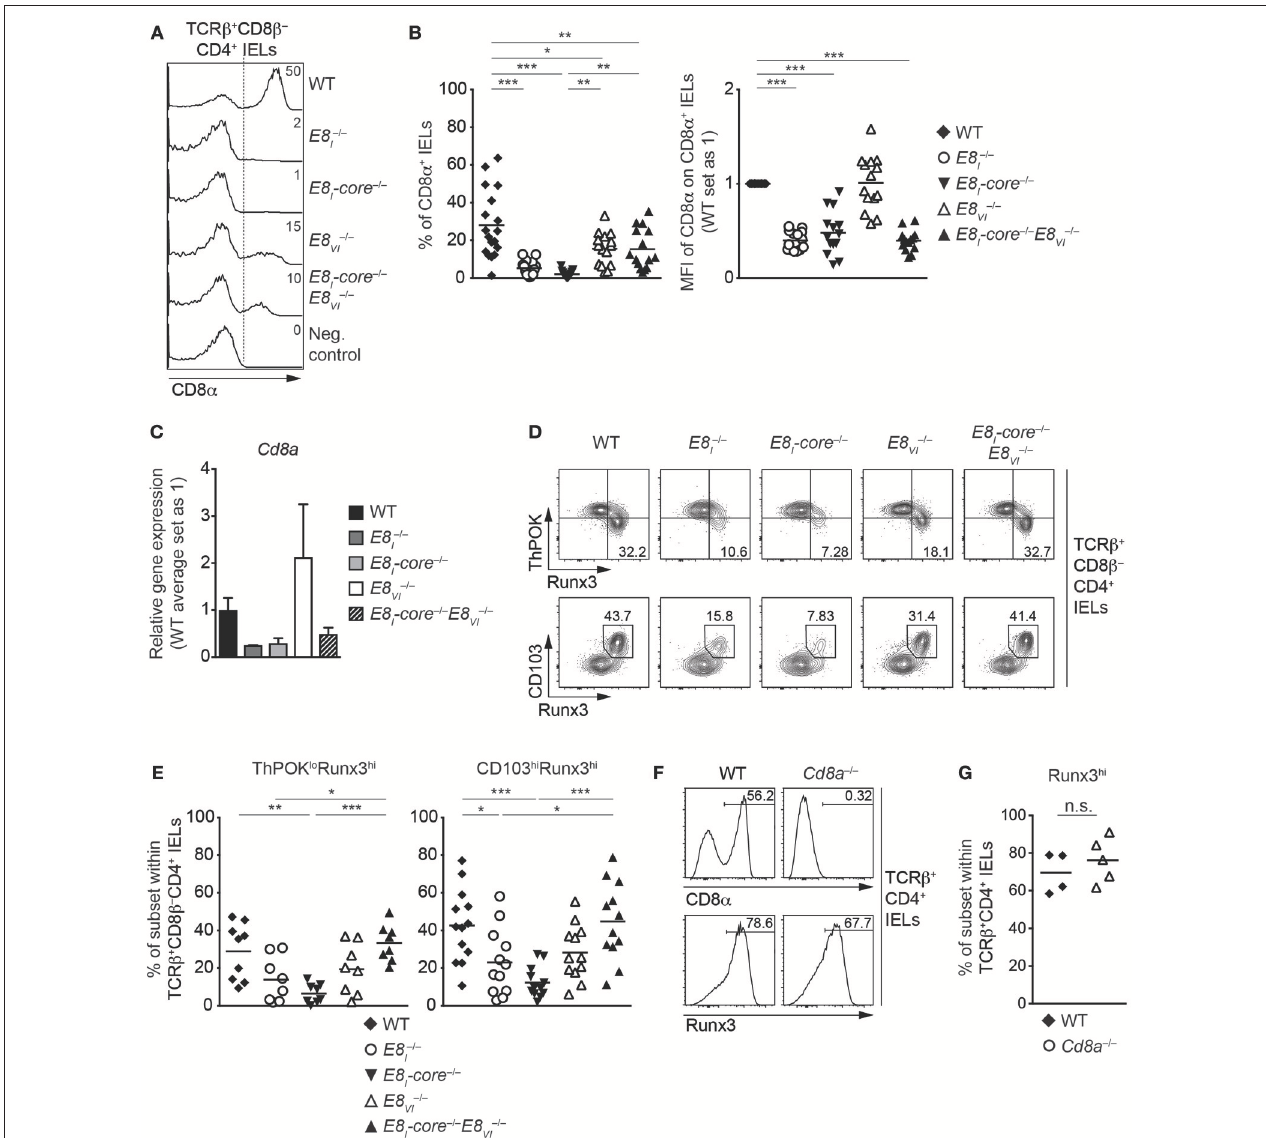
FIGURE 7 | E8 I -core is required for the generation of CD4 + CTLs in the small intestine. (A) Histograms showing CD8 α expression on TCR β + CD8 β − CD4 + IELs isolated from wild-type (WT), E8 I − / − , E8 I - core − / − , E8 VI − / − and E8 I -core − / − E8 VI − / − mice. The gating strategy is shown in Figure 6A . CD8 α expression on WT CD19 + B cells is shown as a negative control for the staining. Dotted lines and numbers indicate gating region for the CD8 α + population and the percentages of the CD8 α + population, respectively. (B) Diagrams showing the percentage of the CD8 α + population (left) and the relative mean fluorescence intensity (MFI) of CD8 α expression on the CD8 α + population (right) within TCR β + CD8 β − CD4 + IELs isolated from wild type (WT), E8 I − / − , E8 I -core − / − , E8 VI − / − and E8 I -core − / − E8 VI − / − mice. Each dot represents one mouse. Horizontal bars indicate mean values. The MFI values of WT cells are set as 1. A one-way ANOVA analysis followed by Tukey’s multiple-comparison test (left) or a one-sample t -test, where the values obtained from each group of the mutant mice were compared to the WT ones (i.e., 1) (right), was performed. (C) qRT-PCR analysis showing Cd8a gene expression levels (normalized to the Hprt gene expression levels) in sorted TCR β + CD8 β − CD4 + IELs from wild-type (WT), E8 I − / − , E8 I - core − / − , E8 VI − / − , and E8 I -core − / − E8 VI − / − mice. The average expression levels in WT cells were set as 1. Error bars indicate SEM. A one-way ANOVA analysis followed by Tukey’s multiple-comparison test was performed for statistical analysis. (D) Flow cytometry analysis showing Runx3 and ThPOK (upper panel) and Runx3 and CD103 (lower panel) expression on TCR β + CD8 β − CD4 + IELs isolated from wild type (WT), E8 I − / − , E8 I -core − / − , E8 VI − / − and E8 I -core − / − E8 VI − / − mice. Numbers indicate the percentages of ThPOK lo Runx3 hi subsets (upper panel) and CD103 hi Runx3 hi subset (lower panel). (E) Diagrams showing the percentages of the ThPOK lo Runx3 hi (left panel) and CD103 hi Runx3 hi (right panel) subsets within TCR β + CD8 β − CD4 + IELs isolated from wild type (WT), E8 I − / − , E8 I -core − / − , E8 VI − / − and E8 I -core − / − E8 VI − / − mice. Each dot represents one mouse. Horizontal bars indicate mean values. A one-way ANOVA analysis followed by Tukey’s multiple-comparison test was performed for statistical analysis. (B,E) The p -values were defined as following: *, p < 0.05; **, p < 0.01; ***, p < 0.001. (F) Histograms showing CD8 α (upper panel) and Runx3 (lower panel) expression on TCR β + CD8 β − CD4 + IELs isolated from wild type (WT) and Cd8a − / − mice. Numbers indicate the percentages of respective regions. (G) Diagrams showing the percentages of the Runx3 hi subset within TCR β + CD8 β − CD4 + IELs isolated from wild type (WT) and Cd8a − / − mice. Each dot represents one mouse. Horizontal bars indicate mean values. An unpaired Student’s t -test was performed for statistical analysis. n.s., not significant. Data are representative (A,D,F) or show the summary of 15-18 mice (A,B) , 3–4 independent biological samples (C) , 8–13 mice (D,E) and 4–5 mice (F,G) analyzed in 16 (A,B) , 2 (C) 8–12 (D,E) , and 2 (F,G) independent